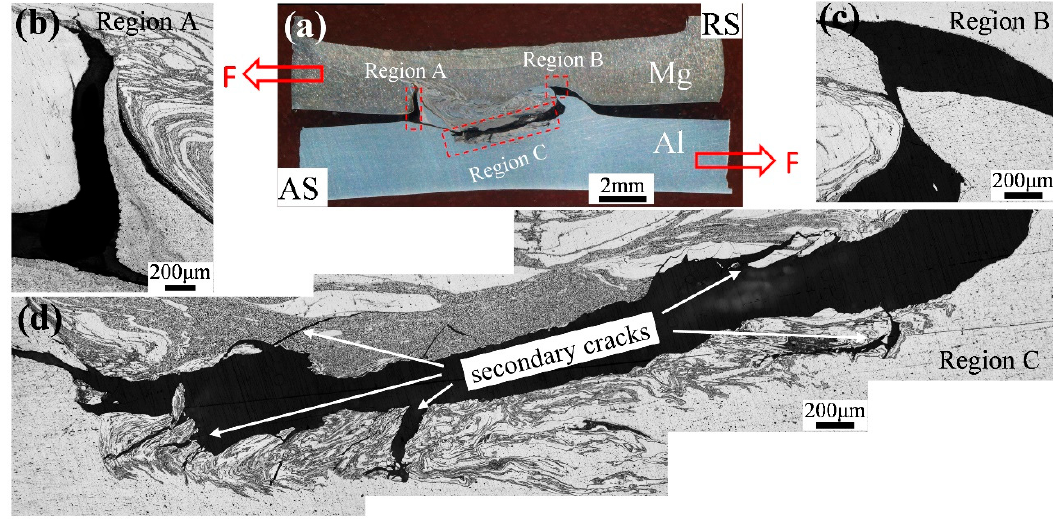
Figure 13. Macro- and micro-structures of the cross section of the failure joints welded in Configuration Mg-Al at 700 rpm: ( a ) macro-structure; ( b ) hook; ( c ) cold lap; ( d ) bottom of the SZ.